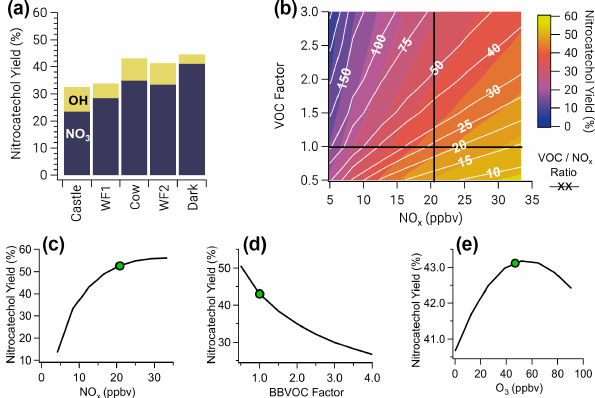
Figure 9. (a) Nitrocatechol yield for all model runs colored by the fraction of nitrocatechol formed from NO 3 and OH oxidation of catechol. Panels (b) – (e) are shown for the Cow model run, which is representative of all other runs. (b) Two overlaid contour plots of VOC / NO x ratio (white lines and white text) and nitrocatechol yield (color scale), with black cross sections that intersect at the observed Cow conditions. (c) A cross section of (b) for nitrocatechol yield as a function of NO x (horizontal black line). (d) A cross section of (b) for nitrocatechol yield as a function of BBVOC factor, a multiple of the initial VOC emissions (vertical black line). (e) Nitrocatechol yield as a function of initial O 3 . Green dots in (c–e) indicate ob- served conditions used for the model run. Nitrocatechol is primarily formed from NO 3 , and the yield increases with increasing NO x but decreases with increasing BBVOC and BBVOC / NO x ratio. Ozone has little effect on nitrocatechol